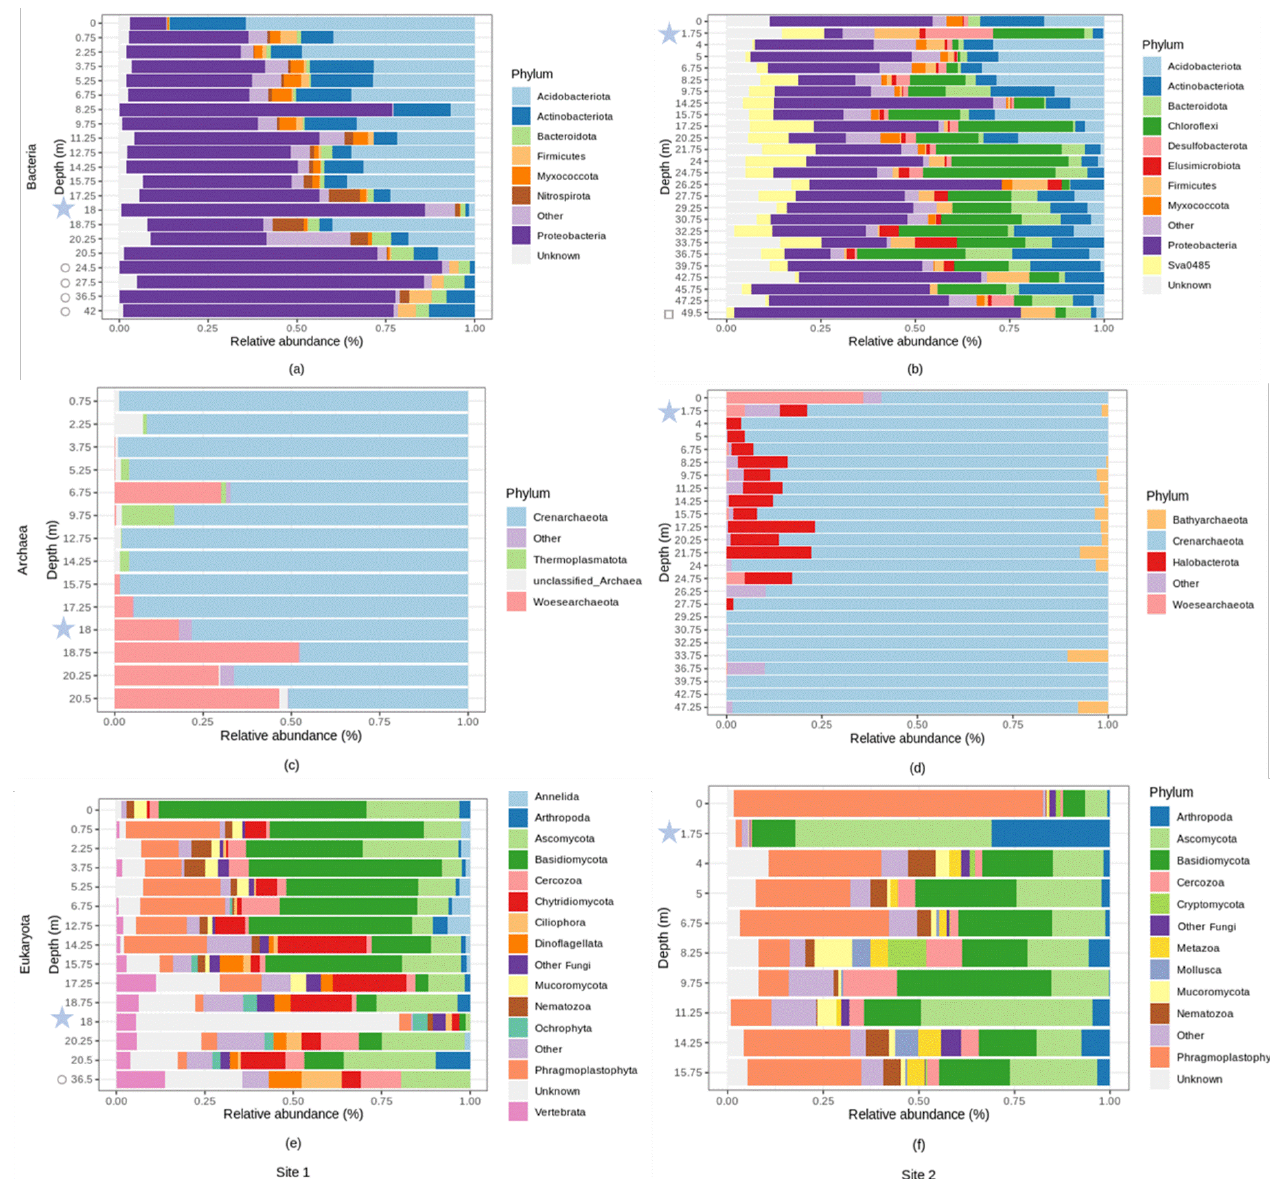
Figure 6. Relative abundance (%) of microbial phyla across different depths (m) at site 1 and at site 2. With: ( a ) bacterial relative abundance at site 1, ( b ) bacterial relative abundance at site 2, ( c ) archaeal relative abundance at site 1, ( d ) archaeal relative abundance at site 2, ( e ) eukaryotic relative abundance at site 1, ( f ) eukaryal relative abundance at site 2. Phyla with an average relative abundance of less than 1% were categorized as “Other”. Bedrock samples are indicated by hollow symbols. Groundwater samples are located at 18 m and 1.75 m of depth, at site 1 and 2, respectively, and are indicated by blue stars.